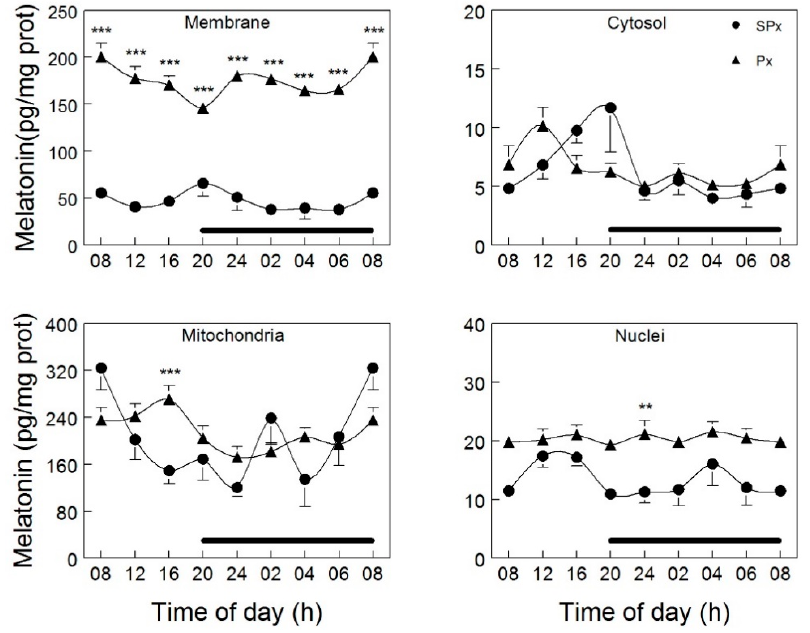
Figure 6. Concentrations and fluctuations of melatonin in organelles obtained from cells of the cerebral cortex of rats that were either intact (SPx) or pinealectomized (Px). Only in cellular membranes did Px markedly change melatonin levels; in this organelle, melatonin values rose substantially as a consequence of pineal removal ( p < 0.001). In the mitochondria and nucleus, at one time point each, melatonin levels were elevated (** p < 0.05 and *** p < 0.001 respectively). Tissues were collected at 4 h intervals over a 24-h light:dark cycle. The period of darkness is identified by the horizontal black bar. What is most apparent is that levels of melatonin in brain mitochondria greatly exceed its values in other subcellular locations. Figure provided by Dario Acuna-Castroviejo.